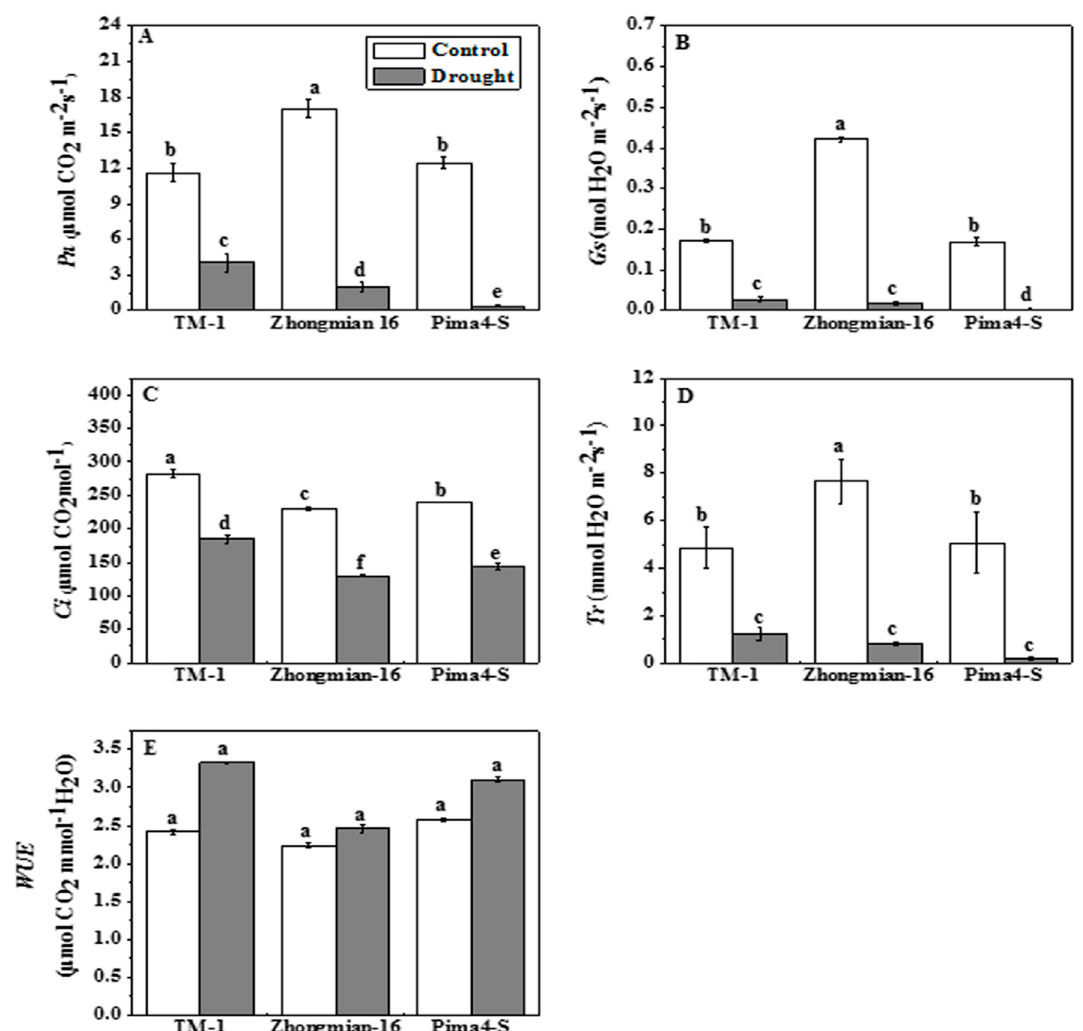
Figure 2. Effect of drought stress on net photosynthetic rate ( P n , A ); stomatal conductance ( G s , B ); intercellular CO 2 concentration ( C i , C ); transpiration ( T r , D ) and water use efficiency (WUE, E ) of the second fully expanded leaves in three cotton species. Means denoted by the same letter are not significantly different at p < 0.05. Error bars are ±SD ( n = 4).